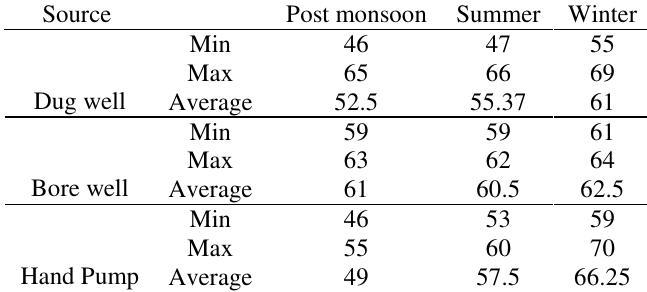
Table 1. Water Quality Index scale recommended by NSF.